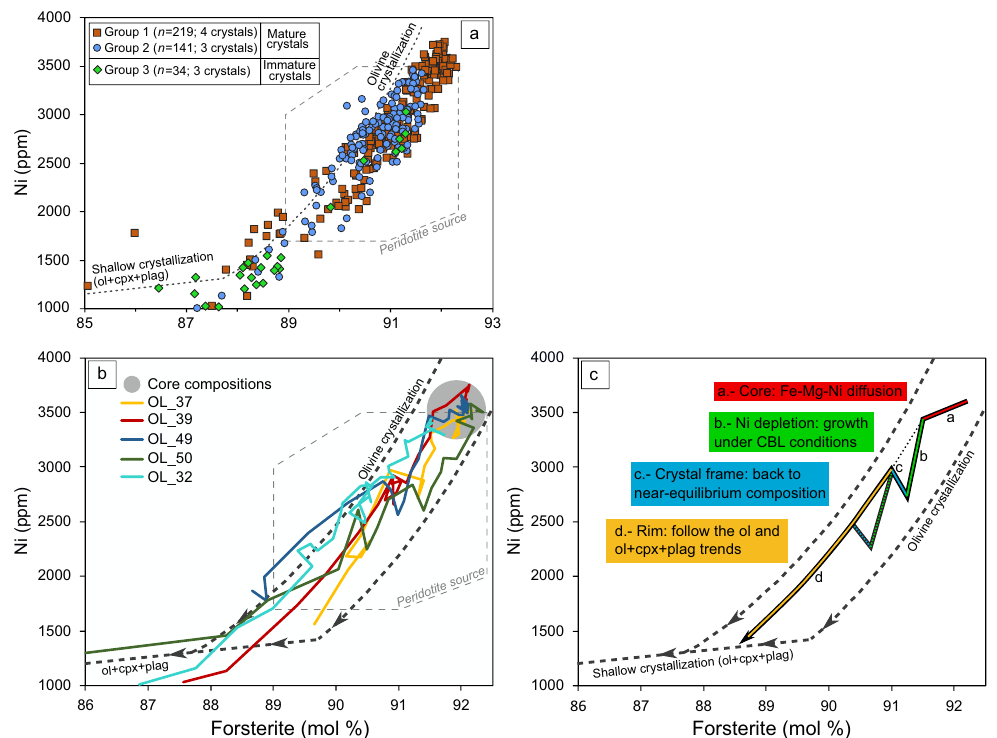
Fig. 3 Distribution of Fo – Ni contents among the different crystal groups and variations along selected crystal pro fi les. a Olivine groups separated by color show that the texturally mature crystals tend to be more primitive whereas the immature olivines are compositionally more evolved. b Core to rim pro fi les of selected crystals. Note the core compositions falling in a restricted Fo – Ni space (gray circle). Rimward, the color-coded crystals share a common evolution pattern, characterized by a sharp Ni decrease accompanied by only a slight variation of Fo, followed by abrupt increments of Ni-only variations at approximately constant Fo. Close to the margins, the crystals chemistry is consistent with co-crystallization of olivine + clinopyroxene ± plagioclase along the crystallization path. c Schematic illustration of the evolution pattern of a -core to rim- section of a model crystal. Labels indicate the crystallization conditions of the different slopes of segments (a – d). The alternative path in segment d shows that some crystals may experience multiple sequences of externally developed crystal frames and Ni depletions followed by a return to equilibrium crystallization, e.g., Olivine 50. CBL: compositional boundary layer. Crystallization lines after Ruprecht and Plank 3 and mantle peridotite fi eld after Straub et al. 71